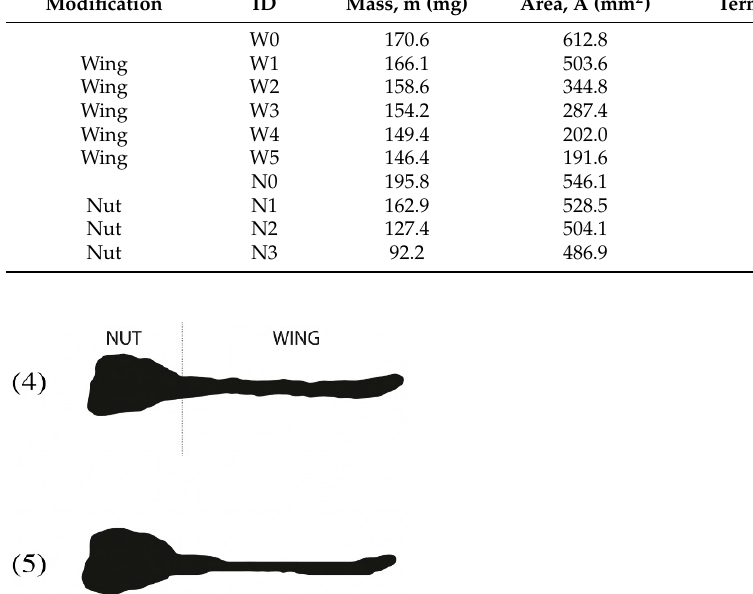
Figure 1. Most heavily modified seeds. Profiles of wing-cut samples 4 and 5 (herein labelled W4 and W5). Reprinted/adapted with permission from Ref. [13]. © IOP Publishing Ltd. and London Mathematical Society 2011. Reproduced with permission. All rights reserved.